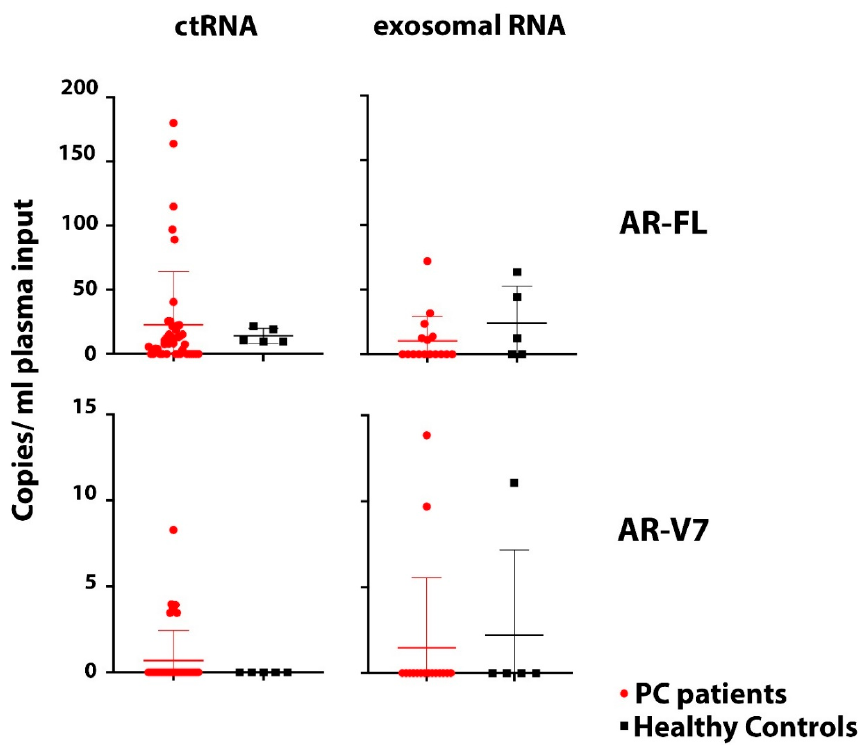
Figure 4. Comparison of AR-FL and AR-V7. AR-FL and AR-V7 detection in ctRNA (44 PC patients, 5 healthy controls) and exosomal RNA samples (16 PC patients and 5 healthy controls) indicates